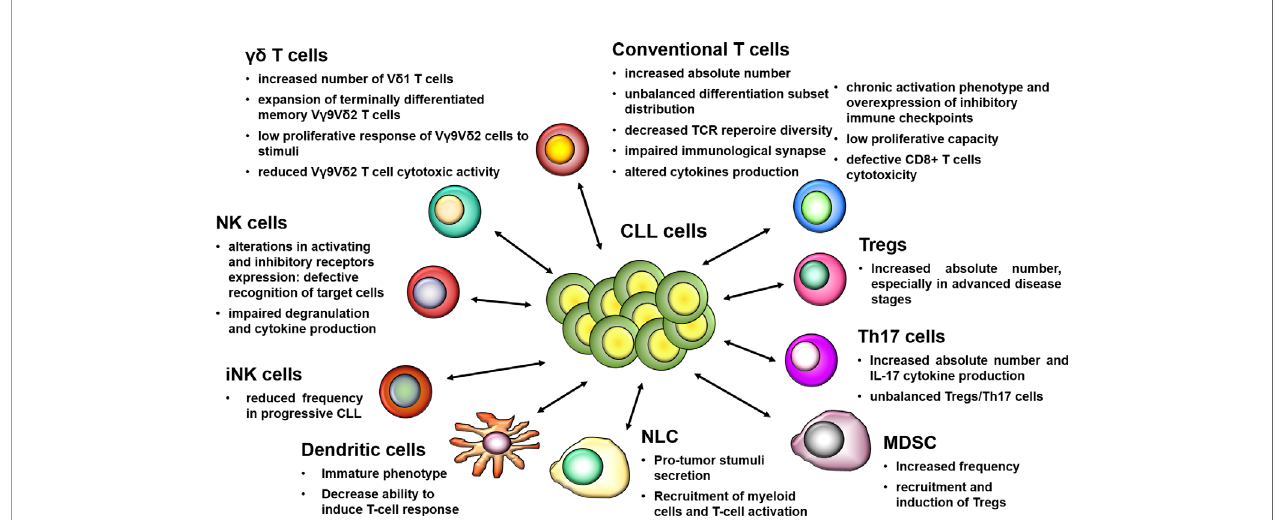
FIGURE 1 | Schematic overview of main defects affecting immune cell populations in CLL. The dysregulation of the immune response in CLL includes phenotypic alterations and functional impairments, which are present since the early stages and exacerbate during the course of the disease, thus promoting immune tolerance and tumor progression. The mutual interactions between leukemic cells and cellular elements of the immune system contribute to the establishment of a permissive or even supportive microenvironment that favors tumor progression, thus playing a key role in immune escape